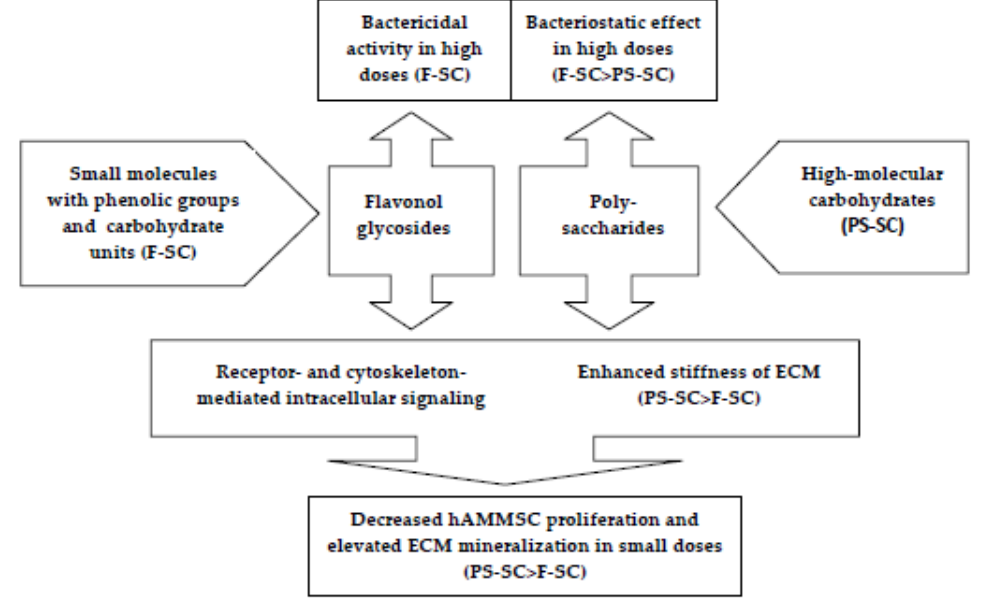
Figure 4. Speculative scheme of common and di ff erent pathways of F-SC and PS-SC in vitro